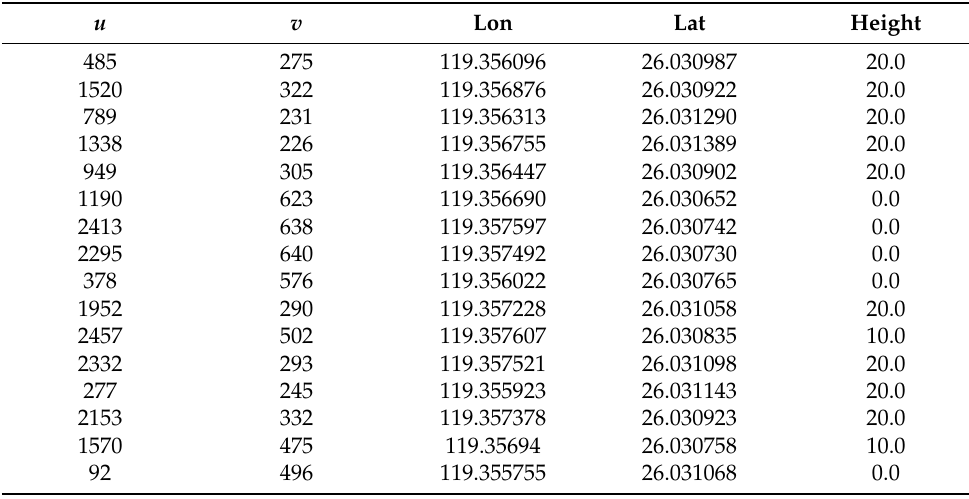
Figure 9. Experimental scene A ( left ) and experimental scene B ( right ). Table 2. Scene A experimental